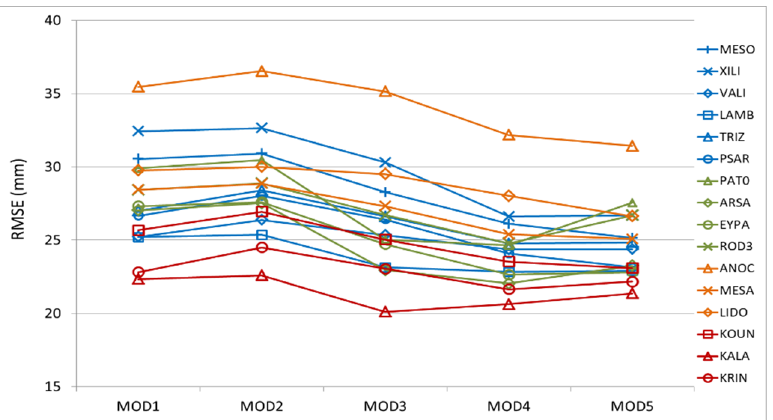
Figure 5. RMSE distribution at the 16 stations, for each model configuration. Stations are col- our-coded, according to their location: blue—coastal; green—inland; orange—upland north; red—upland south.